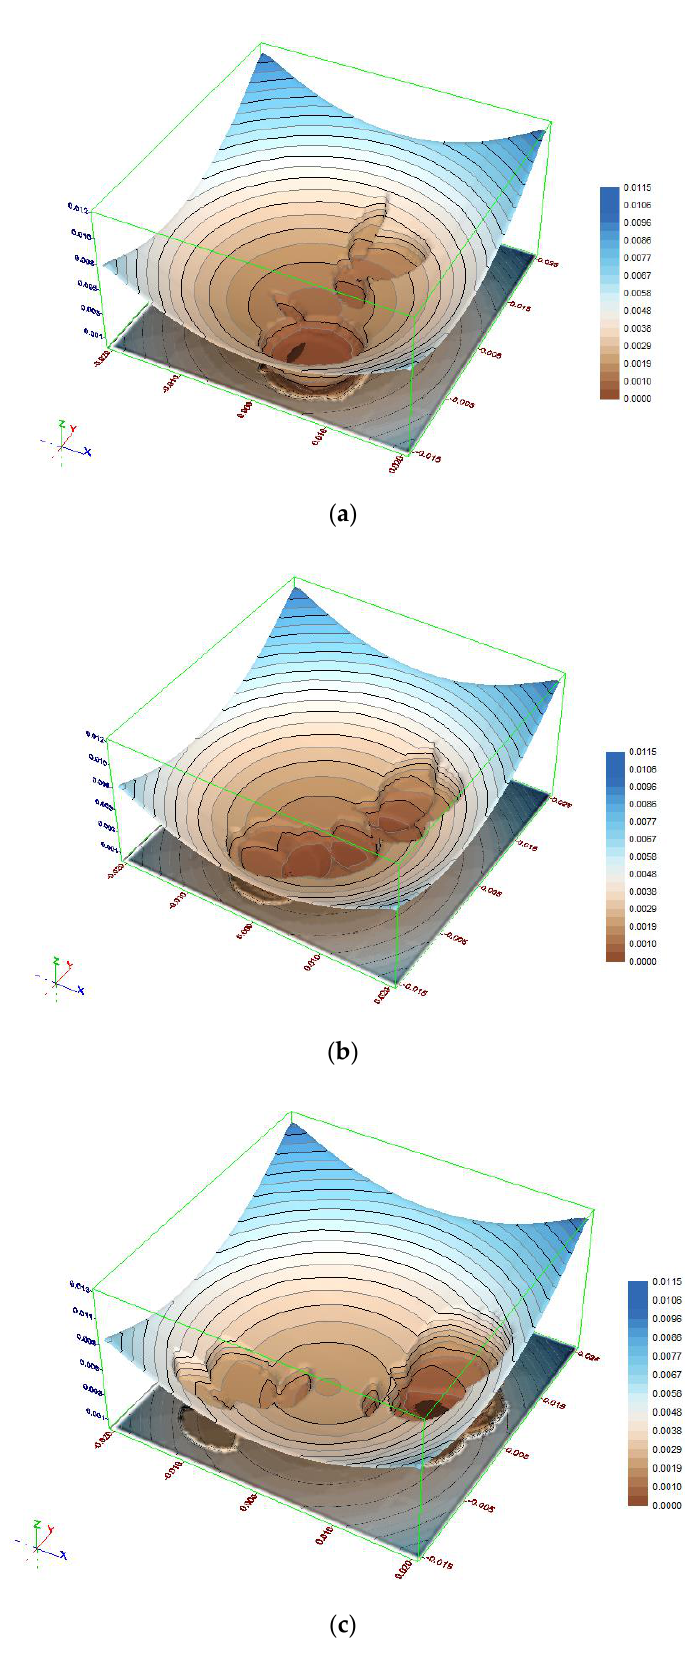
Figure 7. Distribution of the objective function for test object 1 ( a ) δα = 0.0 gon; ( b ) δα = 0.00035 gon; ( c ) δα = 0.0007 gon.